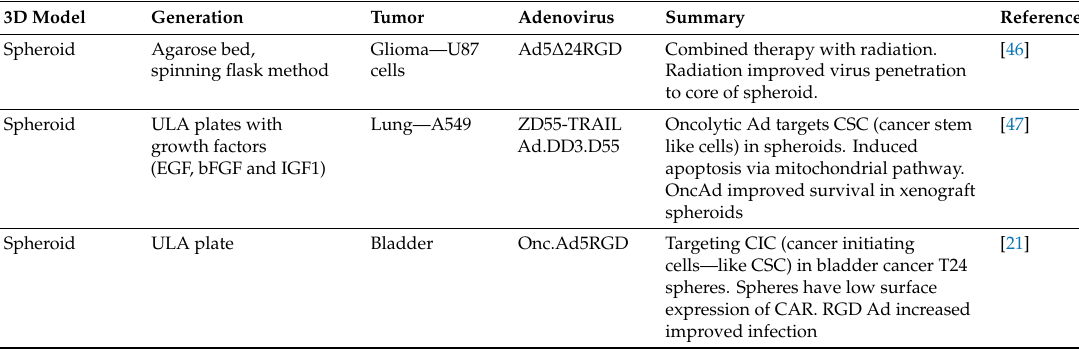
Table 2. Examples of 3D tissue modeling to test oncolytic